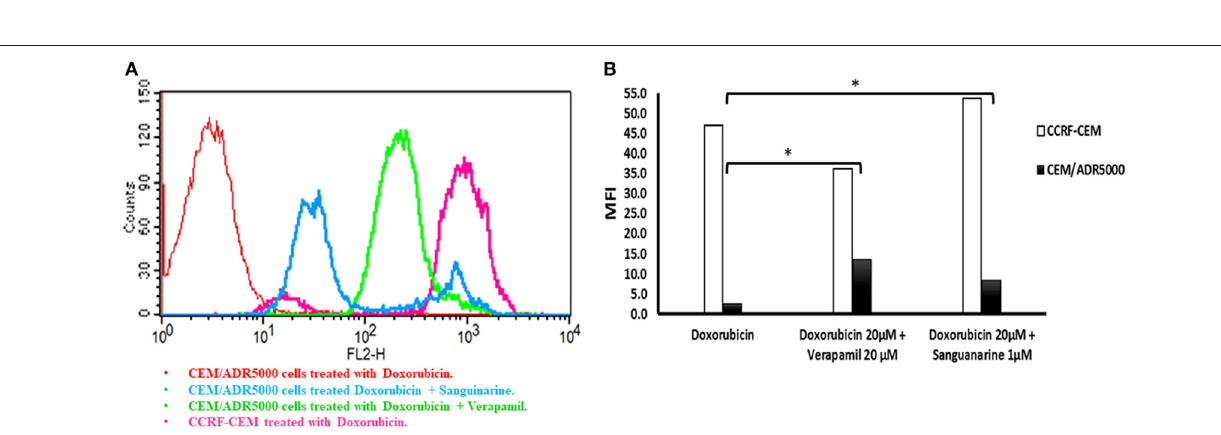
Frontiers in Pharmacology |